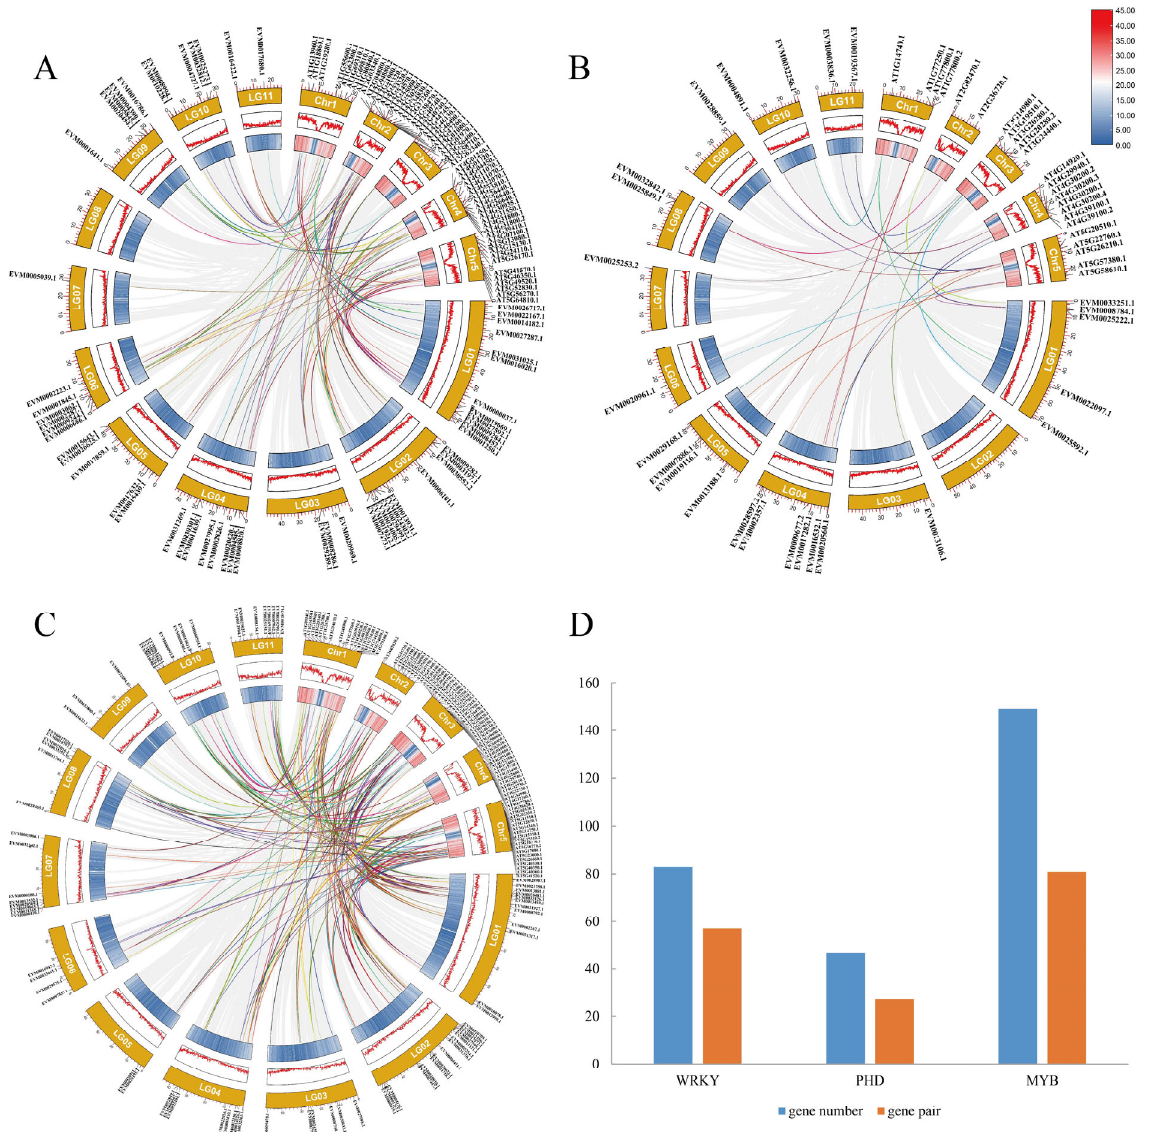
Figure 3. The synteny analysis between mungbeans and Arabidopsis thaliana of three gene families. The synteny analysis of VrWRKYs, VrPHDs, and VrMYBs, respectively ( A – C ). Chr1–Chr5 are the five chromosomes of Arabidopsis and LG01–LG11 represent the 11 chromosomes of mungbean. ( D ) The number of members and collinear gene pairs of the three gene families.